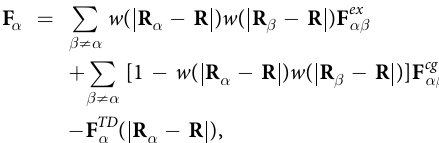
TD where αβ F ex and αβ F cg are the forces between molecules α and β , obtained from the atomistic and coarse-grained potentials, respectively. The sigmoidal function ∈ w [0, 1] is used to smoothly couple the high and low resolution regimes, where R α and R β are two-dimensional (x, y) vectors of centers of mass (COMs) of molecules α and β , respectively. The R is a two-dimensional (x, y) vector to the nearest point on the atomistic-hybrid boundary. Here, we employ the rhombic boundaries between the resolution region boundaries. Since the atomistic-hybrid bound- ary is placed behind the semi-permeable membrane the DNA molecules are at all times modeled at the atomistic scale. Note, that the edges of the hybrid rhombus are rounded. The thermodynamic (TD) force α F TD is needed for the compensation of the difference in the chemical potential of atomistic and coarse-grained resolutions 53, 54 . For each molecule type, the TD force is computed with an iterative procedure as described in detail in refs 48, 53–55